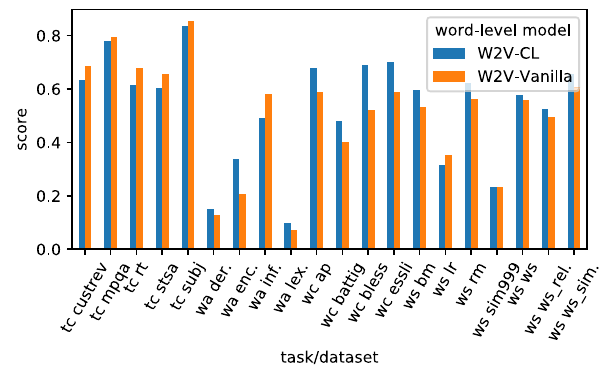
Fig. 15 Different word-level models’ results on word similarity (ws), word analogy (wa), concept categorization (cc) and text classification (tc)